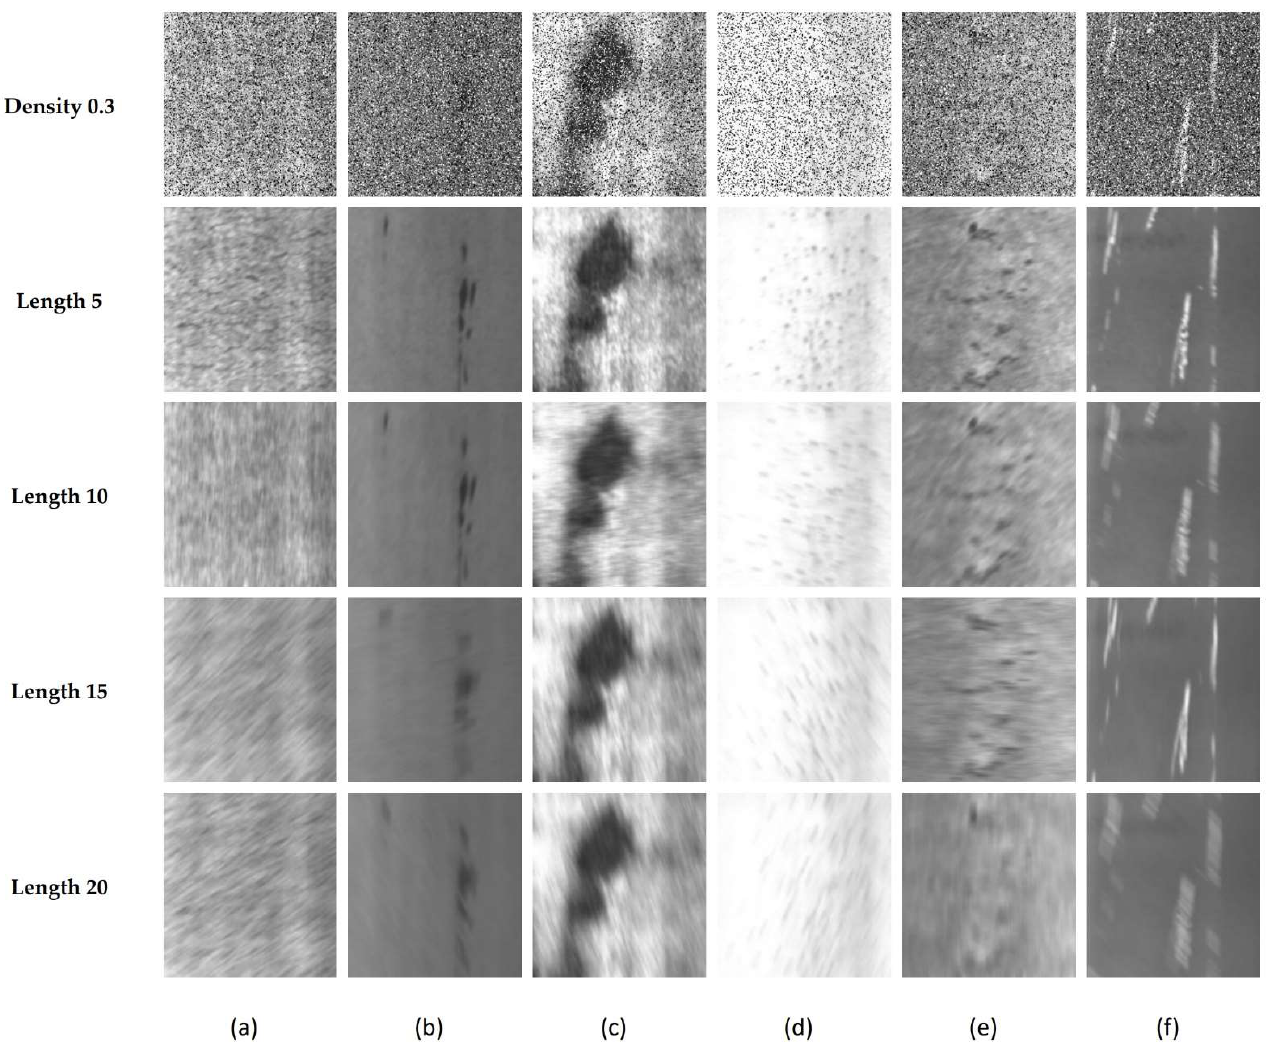
Figure 5. The examples of the disturbance defect dataset. ( a ) Crazing, ( b ) Inclusion, ( c ) Patches, ( d ) Pitted Surface, ( e ) Rolled-in Scale ( f ) Scratches.